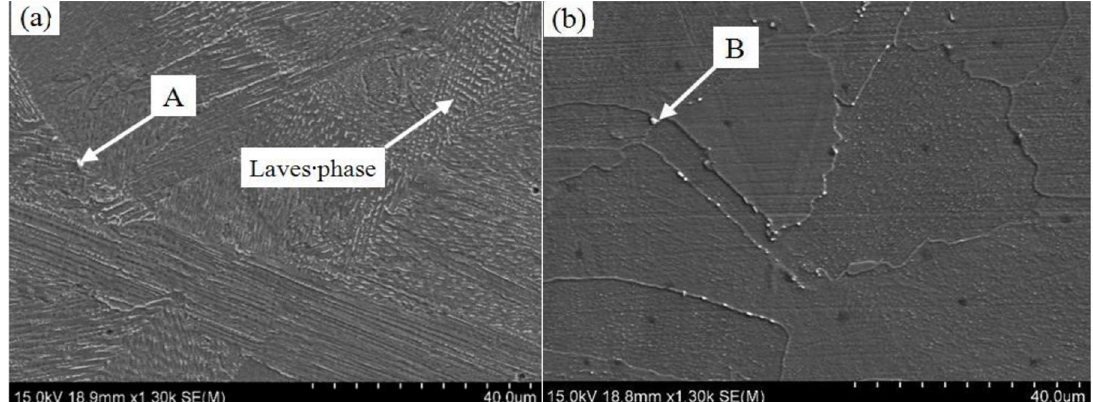
Figure 3. SEM morphology of Inconel-718 Ni-based alloys before and after heat treatment. (a) Morphology of precipitates of unheated; (b) Morphology of precipitates of heat